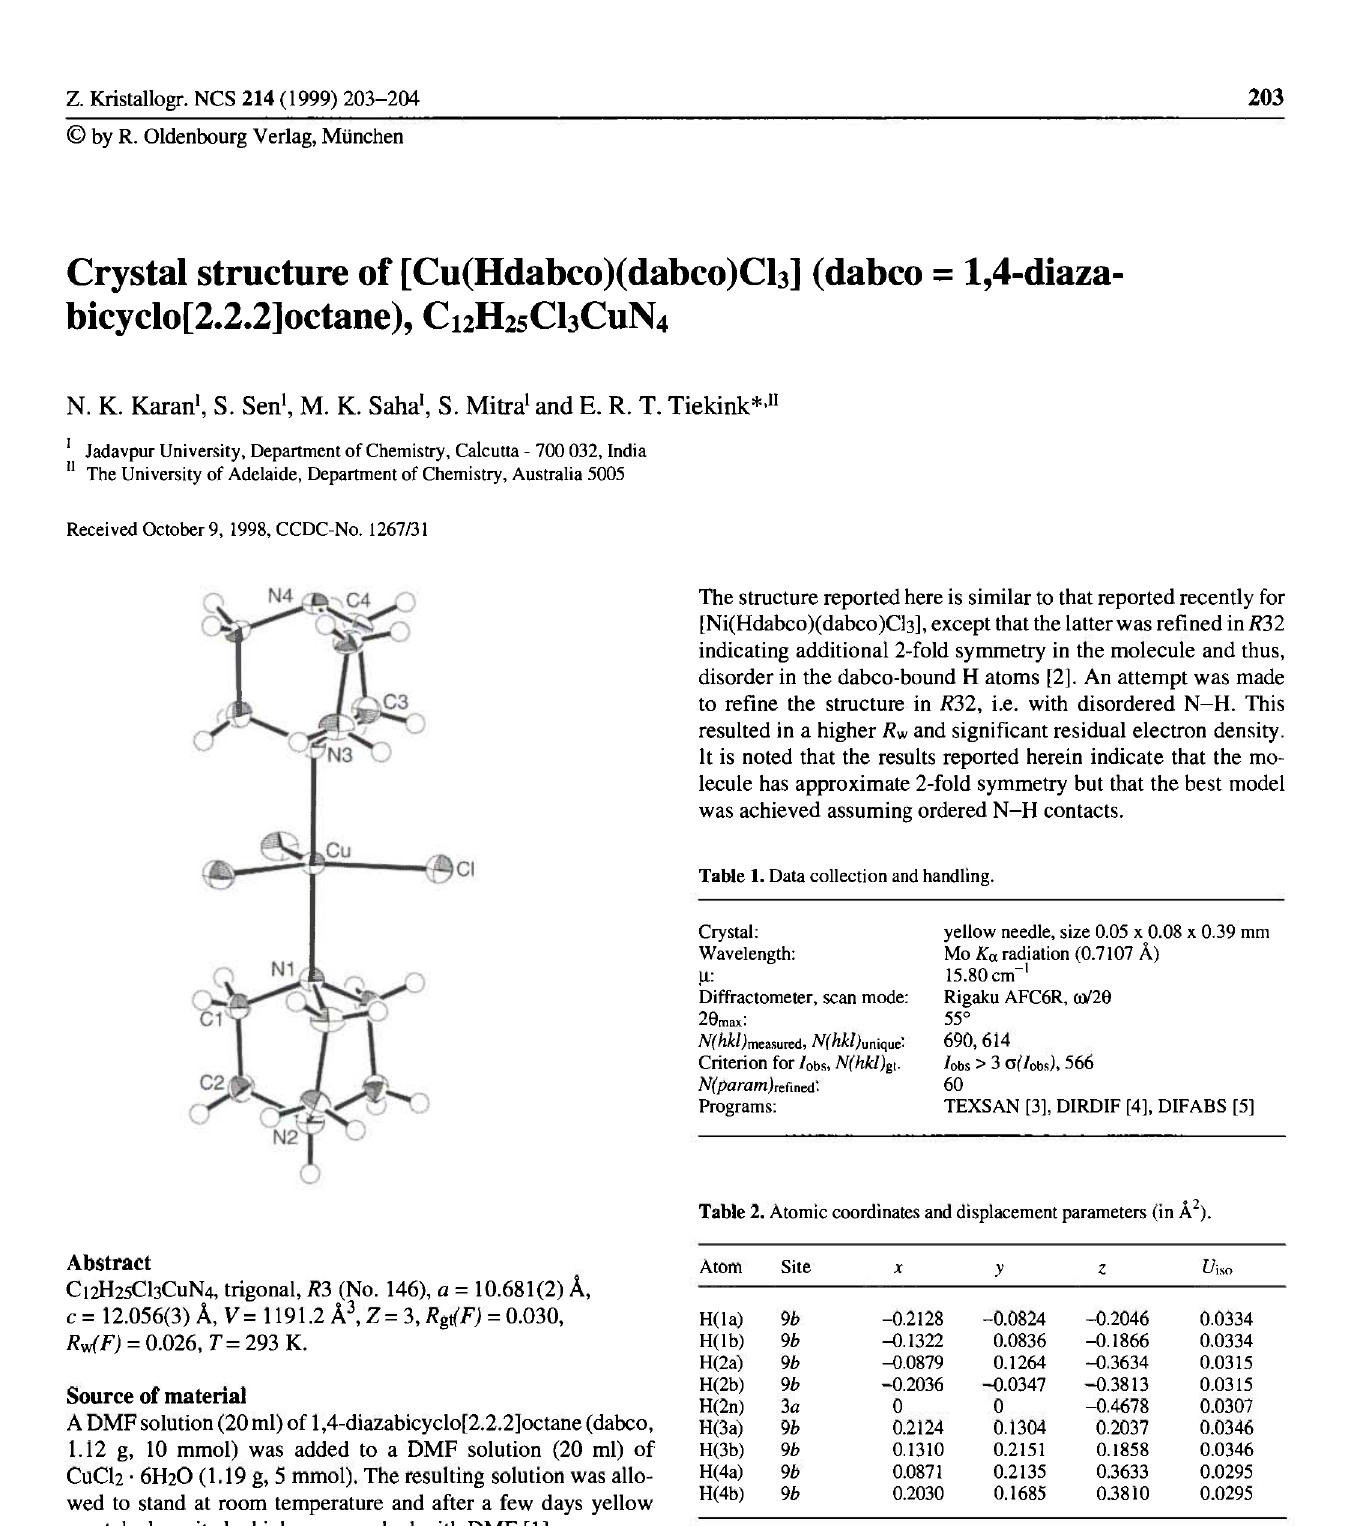
Table 2. Atomic coordinates and displacement parameters (in Ä 2